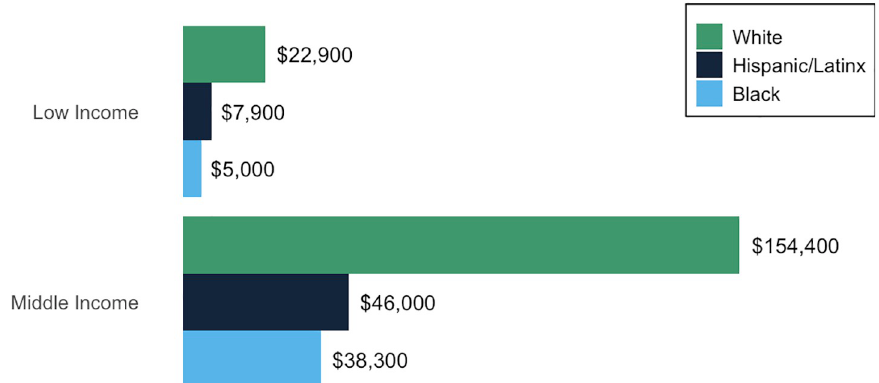
Fig 2. Median net worth of US households. The white and Black categories only include individuals who are not multiracial or of Hispanic/Latinx ethnicity. The high-income category contained an insufficient number of Black and Hispanic/Latinx households to be analyzed separately